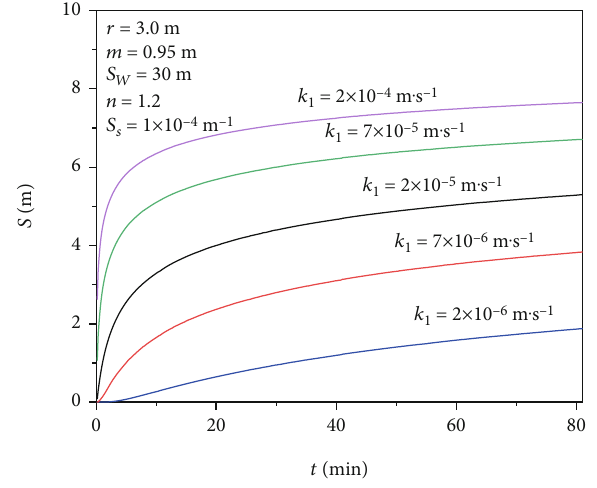
Figure 14: The total sensitivity indices for three uncertain parameters as a function of